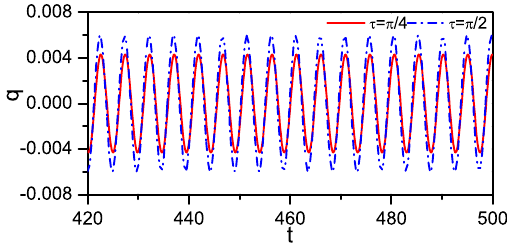
Figure 7. The time history curves of the response of the controlled